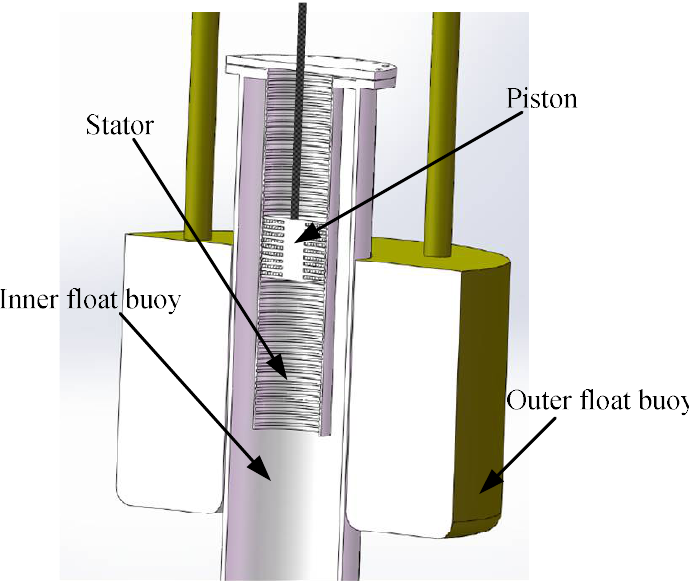
Figure 9. Installation site of Halbach magnetized linear permanent magnet generator.